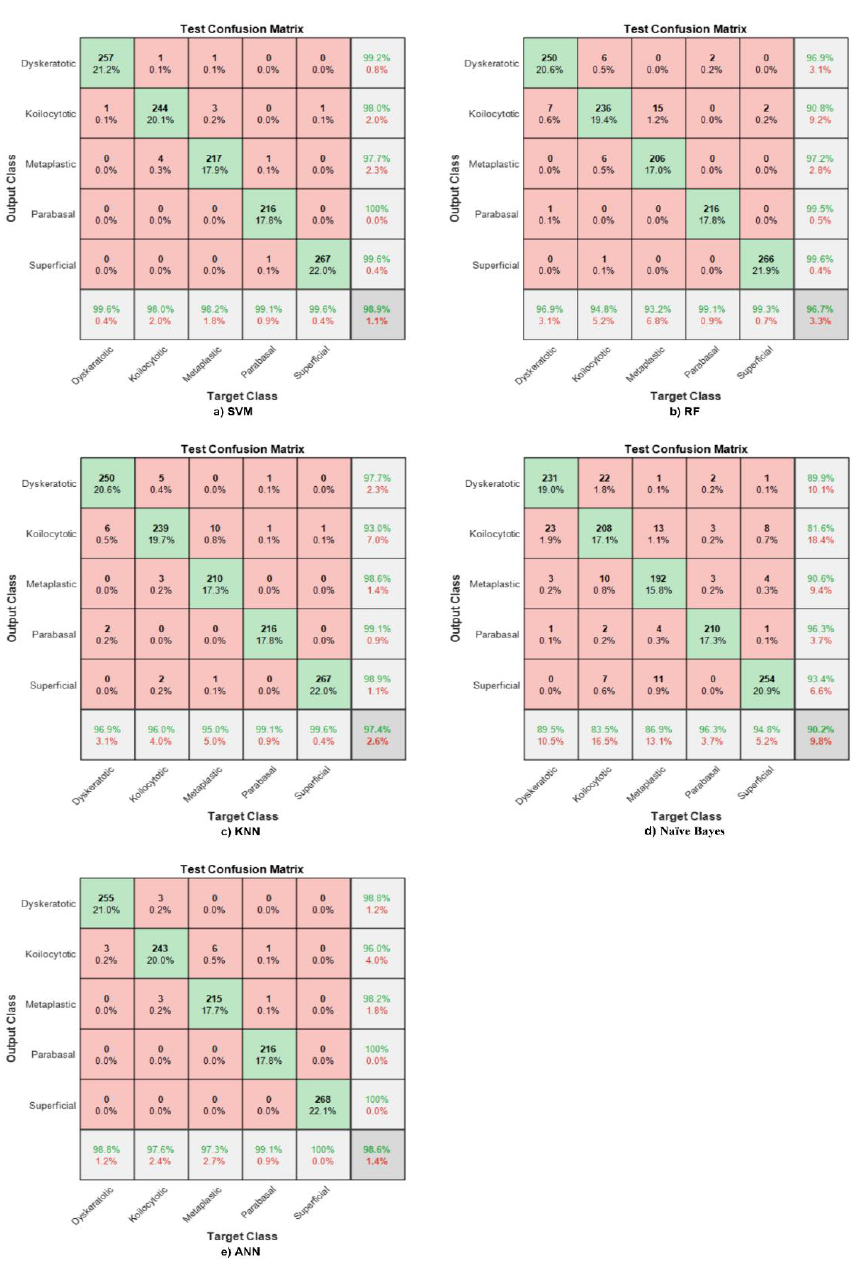
Figure 6. Confusion matrix with respect to Shuffle Net features for different ML classifiers. ( a ) SVM, ( b ) RF, ( c ) KNN, ( d ) Naïve Bays, ( e ) ANN. The same Shuffle Net features are fed to the RF classifier. The overall accuracy reaches 96.5%, and parabasal malignant cells reach the highest PPV, which is 100%.